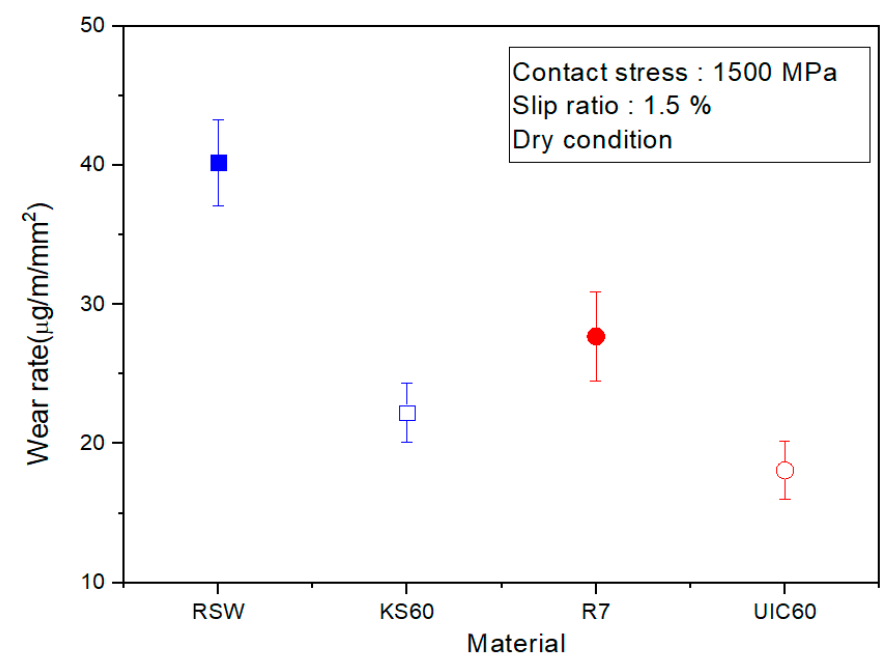
Figure 16. Comparison of wear rate of wheel and rail.